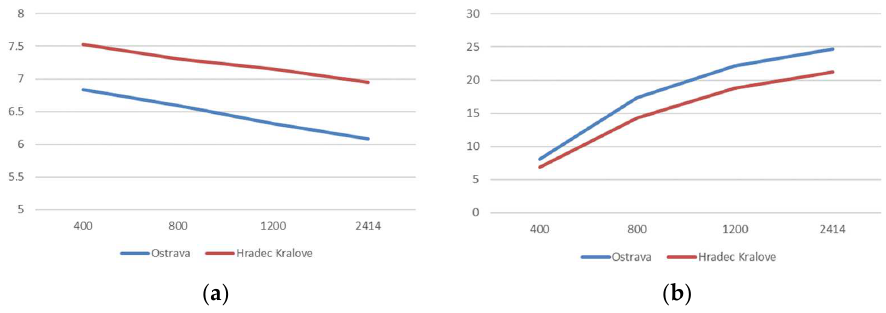
Figure 8. Average changes of WAI ( a ) and WS ( b ) for different buffers in cities. The distribution of population according to walkability is described by cumulative distribution functions in Figure 9. A general effect of increasing population in walkable places with extension of radii is well documented for both indicators. A small radius (400 m) for WAI indicates only a small portion of the population with low WAI and the rest of the population obtains various values of WAI without strong preference. At the largest radius, 20% of the population suffer from very low WAI conditions while the other 80% is almost evenly distributed with higher values of WAI. The graphs confirm that the population distribution of WAI with a growing radius quickly degrades into 2 groups—those living in a poorly walkable environment (mainly on the city periphery) and those in a well walkable environment (in all highly urbanised areas) which is not realistic nor useful. The WS curve documents that a short radius (400 m) causes a high share of the population to possess a low WS and a very limited share of the population enjoys a satisfactory level of WS. However, the situation changes at 800 m, where the curve shows even distribution of WS values across the population: large radii quickly improve walkability and deliver a score above 50 to half the population.